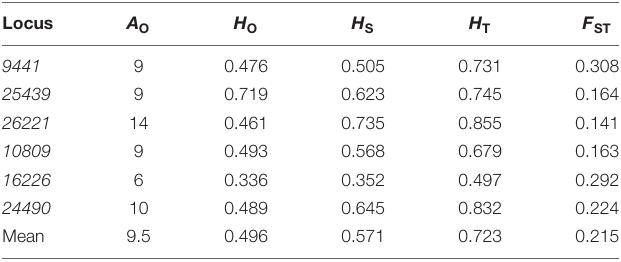
TABLE 2 | Measures of genetic diversity and genetic differentiation at six nuclear microsatellite loci in Speranskia tuberculata . Locus A O H O H S H